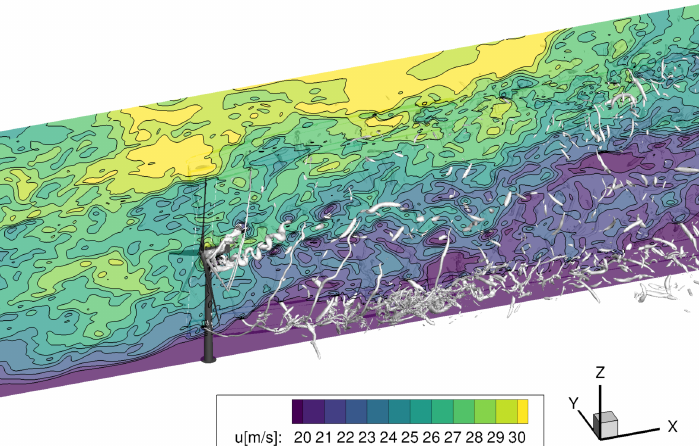
Figure 6. Instantaneous streamwise velocity and λ 2 -isosurfaces in the WT wake flow field of C1 at V W = 11.3m/s. Note that the WT geometry is plotted for more clarity, but was not resolved in the CFD simulation of C1. (OS-1).